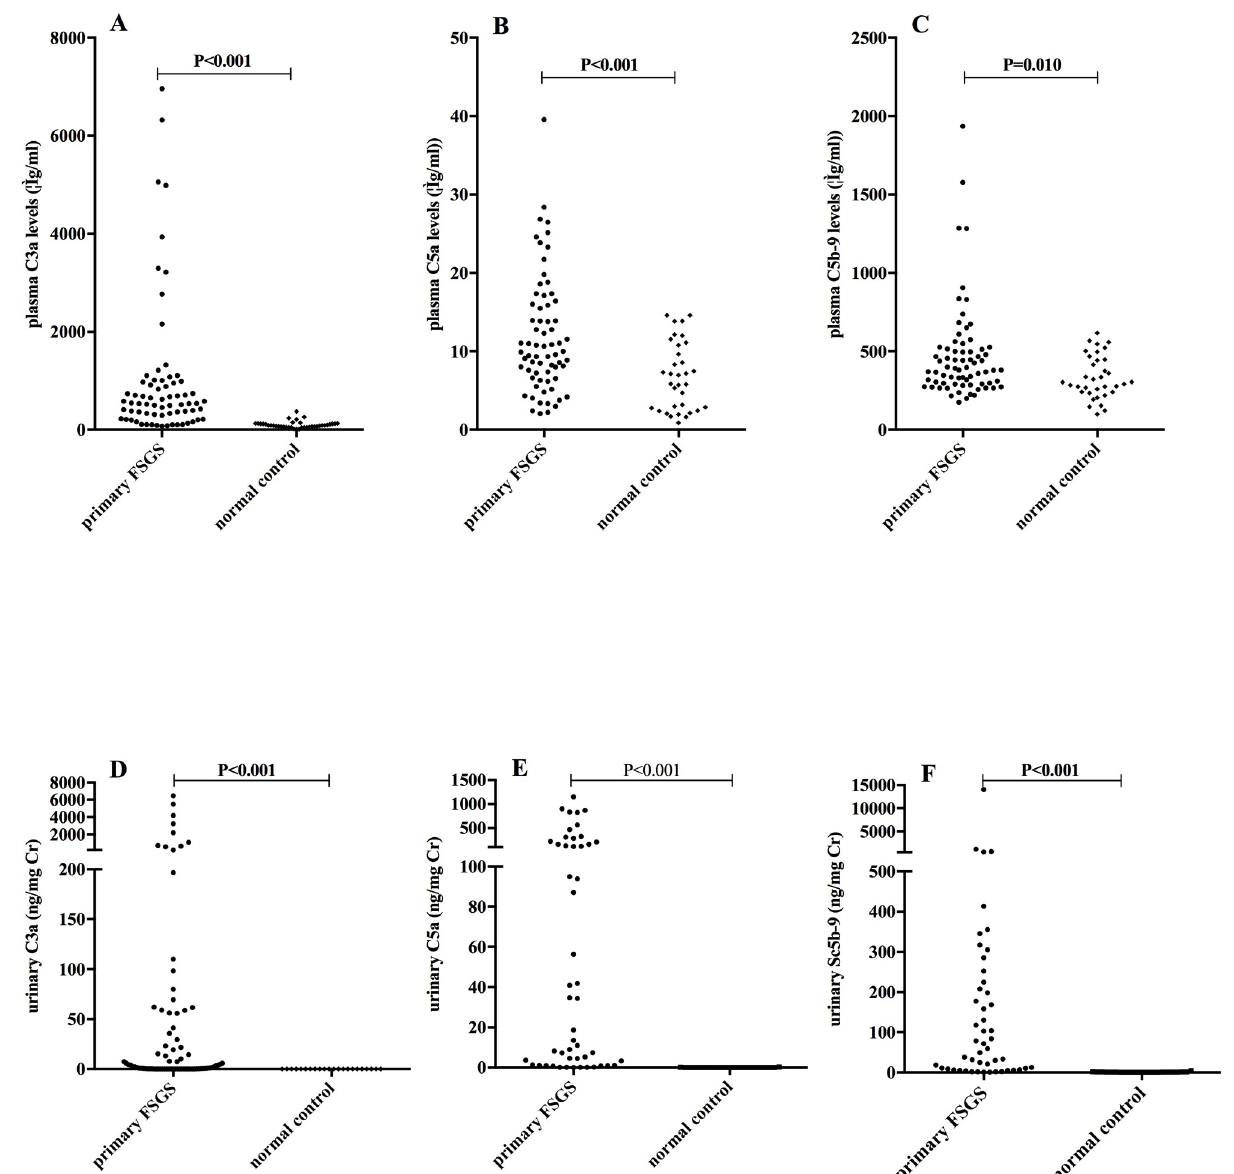
Fig 1. Plasma and urinary C3a, C5a and soluble C5b-9 levels between patients with primary FSGS and normal subjects. The plasma and urinary levels of C3a, C5a and C5b-9 were significantly higher in FSGS.